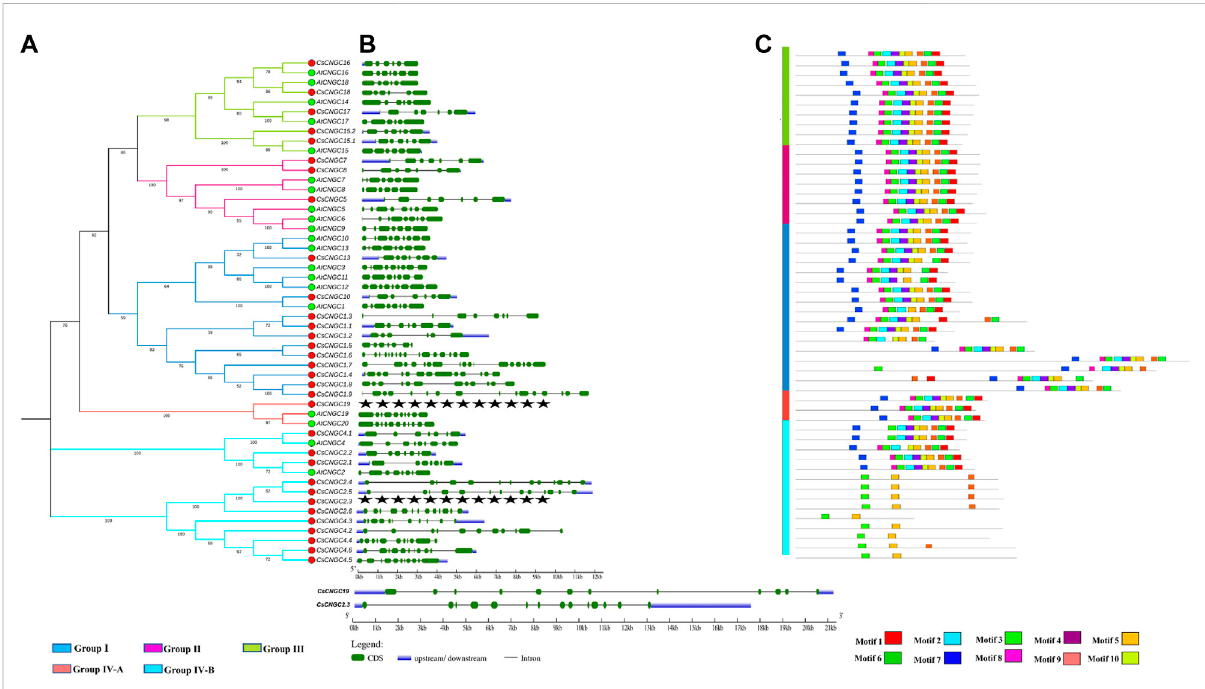
FIGURE 4 (A) Phylogenetic tree constructed at MEGA 7.0 based on Neighbor-Joining method with a bootstrap value of 1,000 replicates using protein sequences of AtCNGCs and CsCNGCs. Red colored circles represent CsCNGCs and green colored circles represent AtCNGCs. (B) Gene structures of AtCNGC and CsCNGC were determined by using GSDS v2.0. (C) Representation of conserved motifs in AtCNGCs and CsCNGCs determined by using MEME suite.